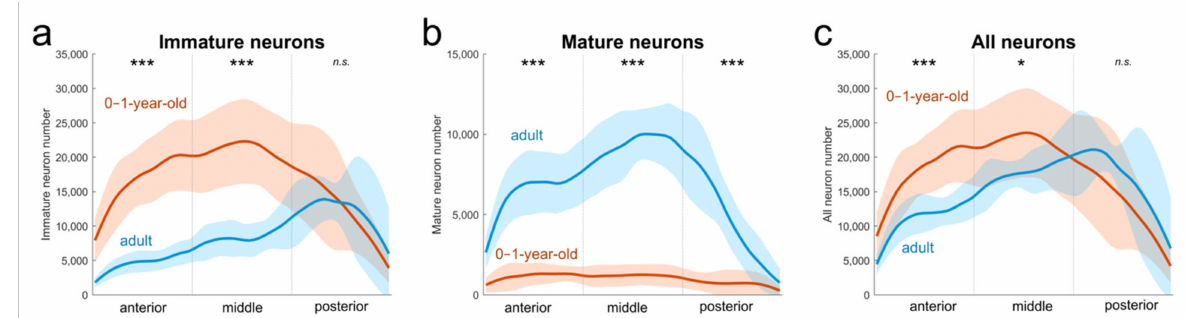
Figure 4. Distribution of immature ( a ), mature ( b ), and all (mature + immature) ( c ) neurons in the paralaminar nucleus of the amygdala in juvenile (< 1 year; n = 20; red), and adult (>5 years; n = 7; blue) control monkeys (average ± SD; *** p < 0.001; * p < 0.05; n.s., no statistically significant difference). Based on neuron number estimates reported in